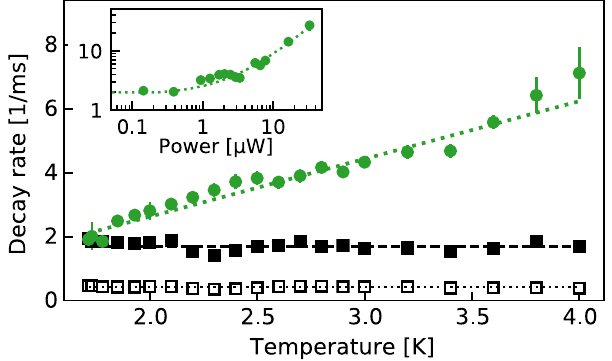
FIG. 4. Temperature dependence. When the temperature of the sample and the exchange gas are increased, the fast (black filled) and slow (black open rectangles) decay constants of the fluo- rescence remain unchanged (black fit lines). In contrast, the decay rate of the coherence increases (green data and linear fit). The inset shows the rise of the decay rate with increased thermo- optical feedback laser power (green data and linear fit). Based on these measurements, we estimate that at the current vibration level, complete stabilization of the resonator at ≈ 5 μ W (cf. Fig. 2) requires a temperature increase of ∼ 2